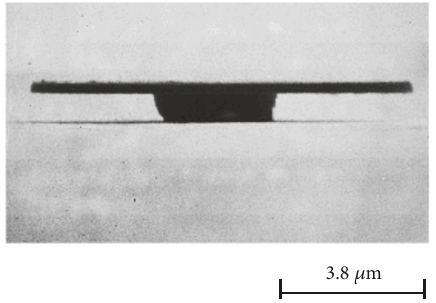
Figure 19: A scanningelectronmicroscopy imageof theside viewof anEr-dopedGaPmicrodiskresonatorwith10 𝜇 mdiameter[adapted from